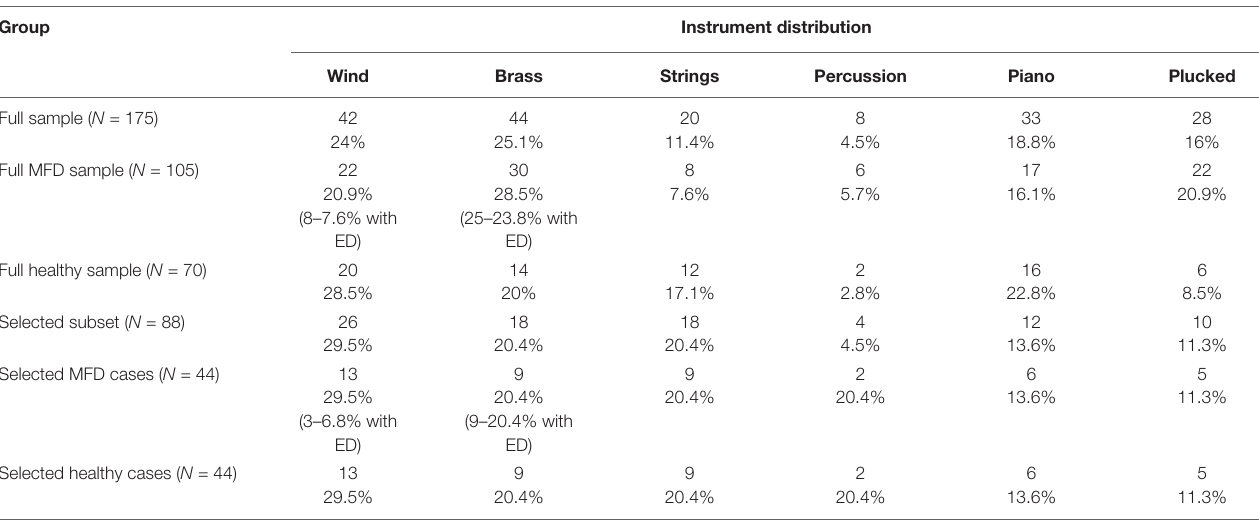
TABLE 2 | Instrument distribution of the